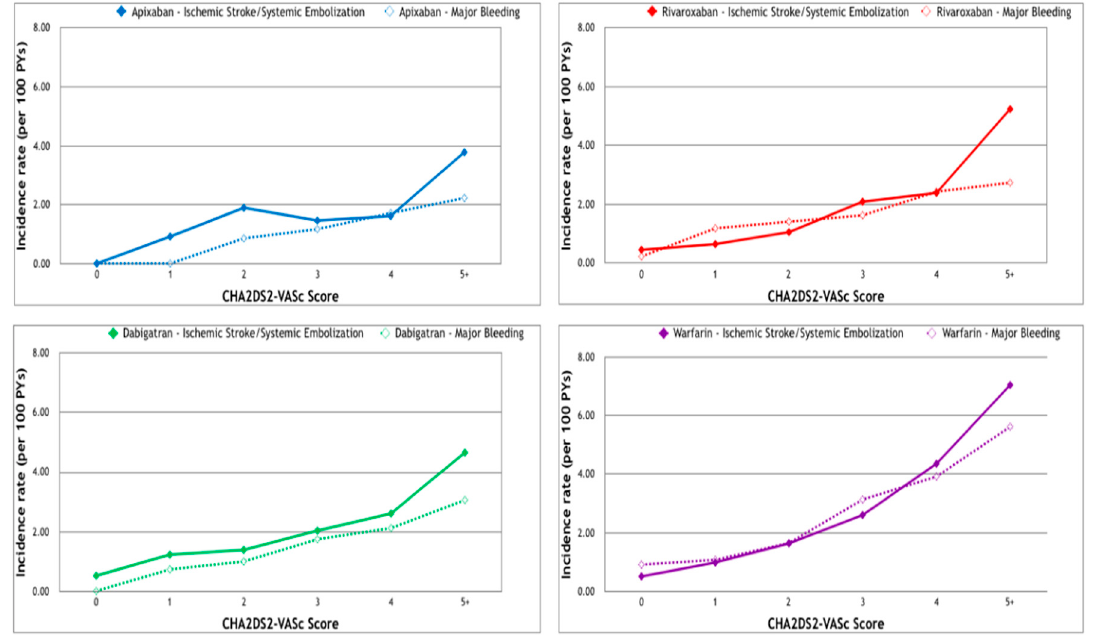
Figure 4. Incidence of major bleeding and ischemic stroke/systemic emboli requiring hospitalization among patients with non-valvular atrial fibrillation receiving oral anticoagulants. Upper left: the apixaban group. Upper right: the rivaroxaban group. Lower left: the dabigatran group. Lower right: the warfarin group.